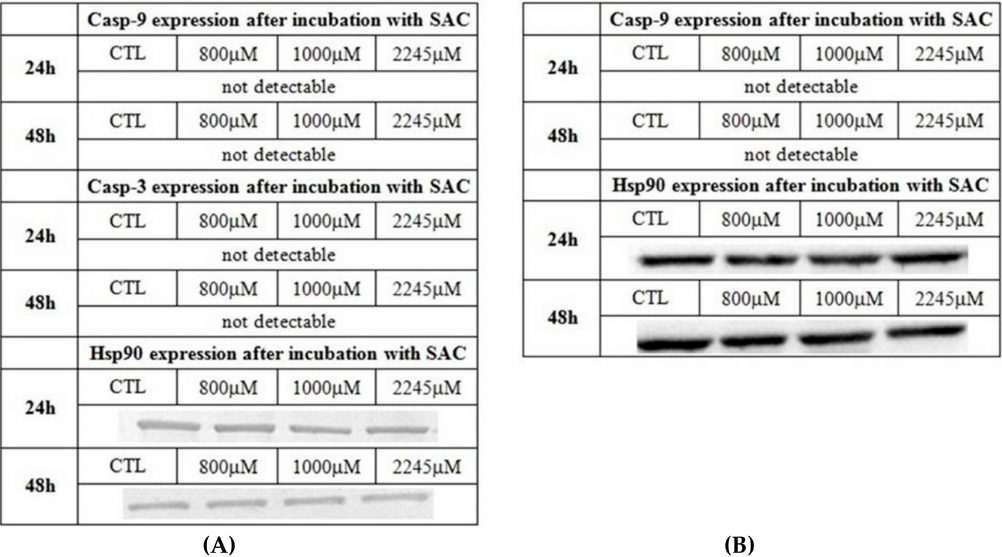
Figure 5. The expression of γ -Cystathionase (CTH) in the breast cancer cell line (MCF-7) after the 24 h and 48 h incubations with SAC. The tested concentrations of SAC in culture medium as listed: 800 µ M, 1000 µ M and 2245 µ M; the control refers to non-treated cells. ( A ) Western blot with immunodetection. Each experiment was done tree times in triplets, and a representative experiment is shown. Hsp90 is used as a control of equal loading. ( B ) Densitometric visualization of the expression of CTH. The error bars represent the standard deviation. ( C ) Western blot with chemiluminescence detection. Statistical analysis was performed using the Mann–Whitney test (* p < 0.1 ** p < 0.05, 800 µ M, 1000 µ M, 2245 µ M SAC vs. control).